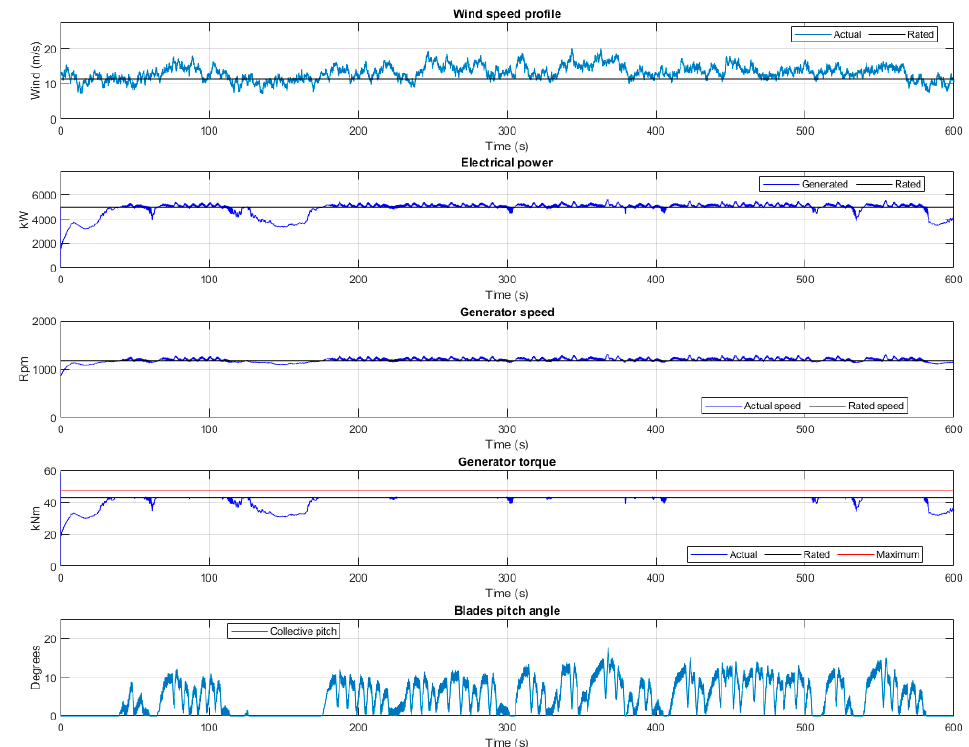
Figure 11. Simulation for improved PI with the Fuzzy Supervisor Control, under a wind profile of average speed of 13 m/s and turbulence A.